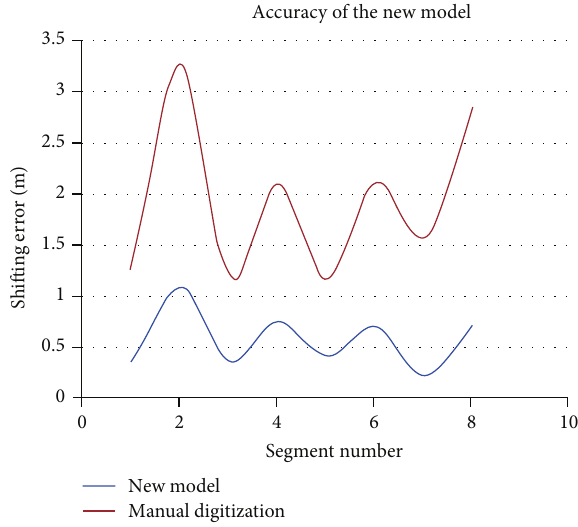
Figure 7: Accuracy of the model compared to the manual